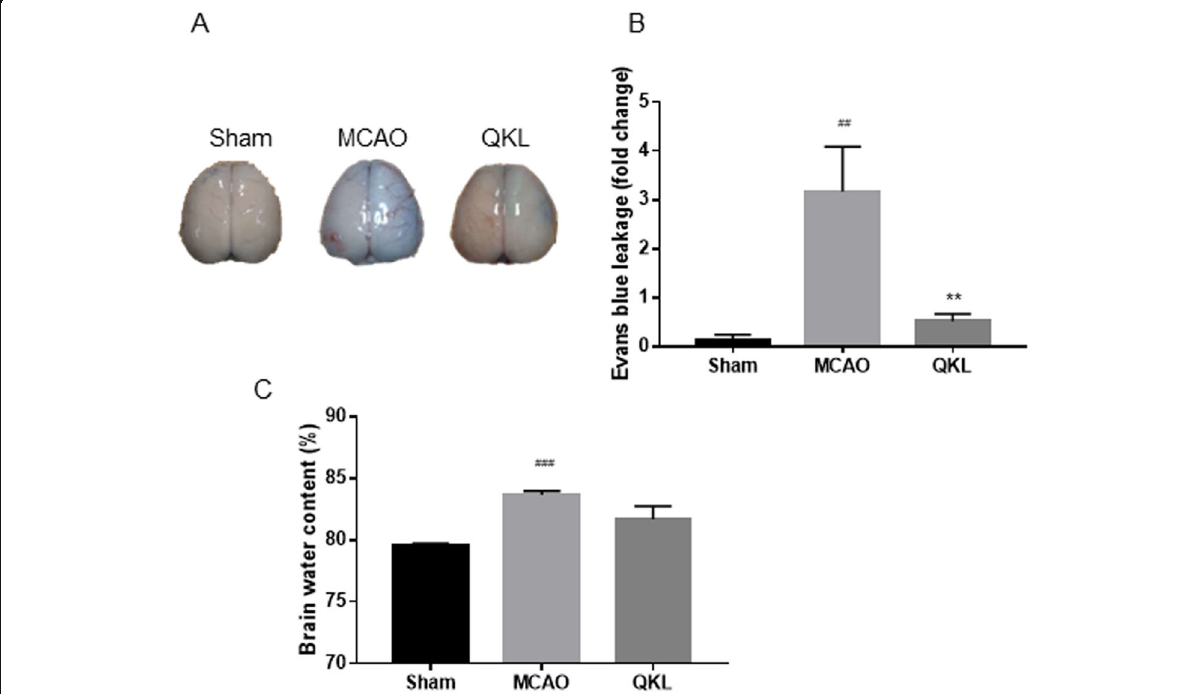
Fig. 2 Effects of QKL on post-stroke blood-brain barrier (BBB) dysfunction. a Representative pictures of Evans blue (EB) leakage analysis. b EB leakage analysis to evaluate prevention of BBB dysfunction by QKL. c Brain water content of each hemisphere. Data points indicate means ± SEM from 6 individual rats in each group. Vs Sham group, ## < 0.01, ### < 0.001, Vs MCAO group, ** p <